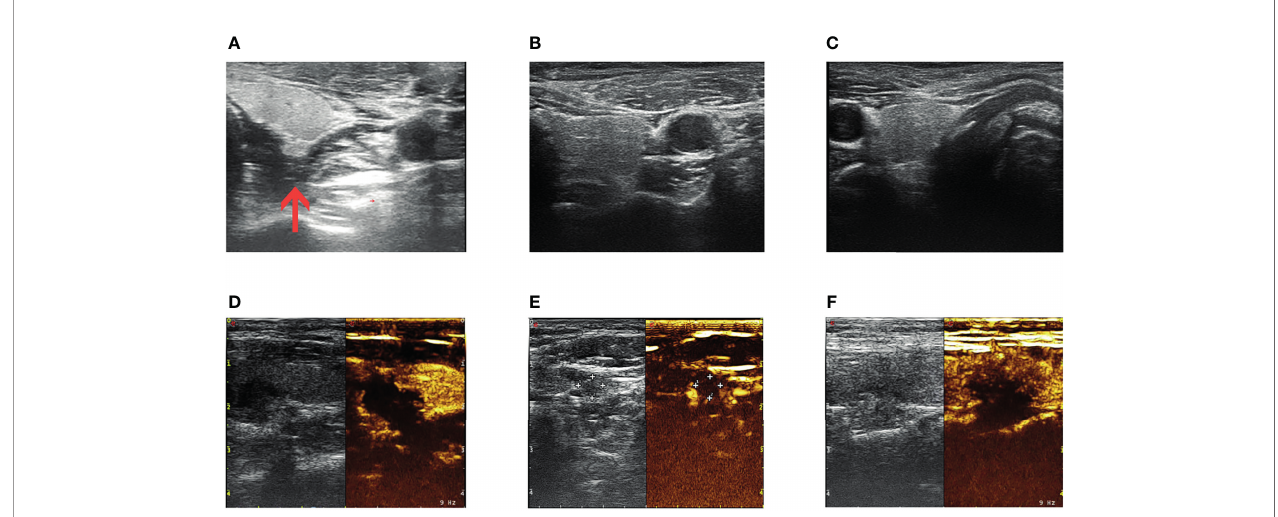
FIGURE 3 | Radiofrequency ablation of the parathyroid glands. Ultrasound images of the left superior (A) , left inferior (B) , and right superior (C) parathyroid glands before radiofrequency ablation. Ultrasound images (left) and ultrasound contrast images (right) of left superior (D) , left inferior (E) , and right superior (F) parathyroid glands after radiofrequency ablation. Red arrow in (A) shows that intraoperative saline and lidocaine mixture were used for local anesthesia and isolation of the left superior parathyroid glands and peripheral